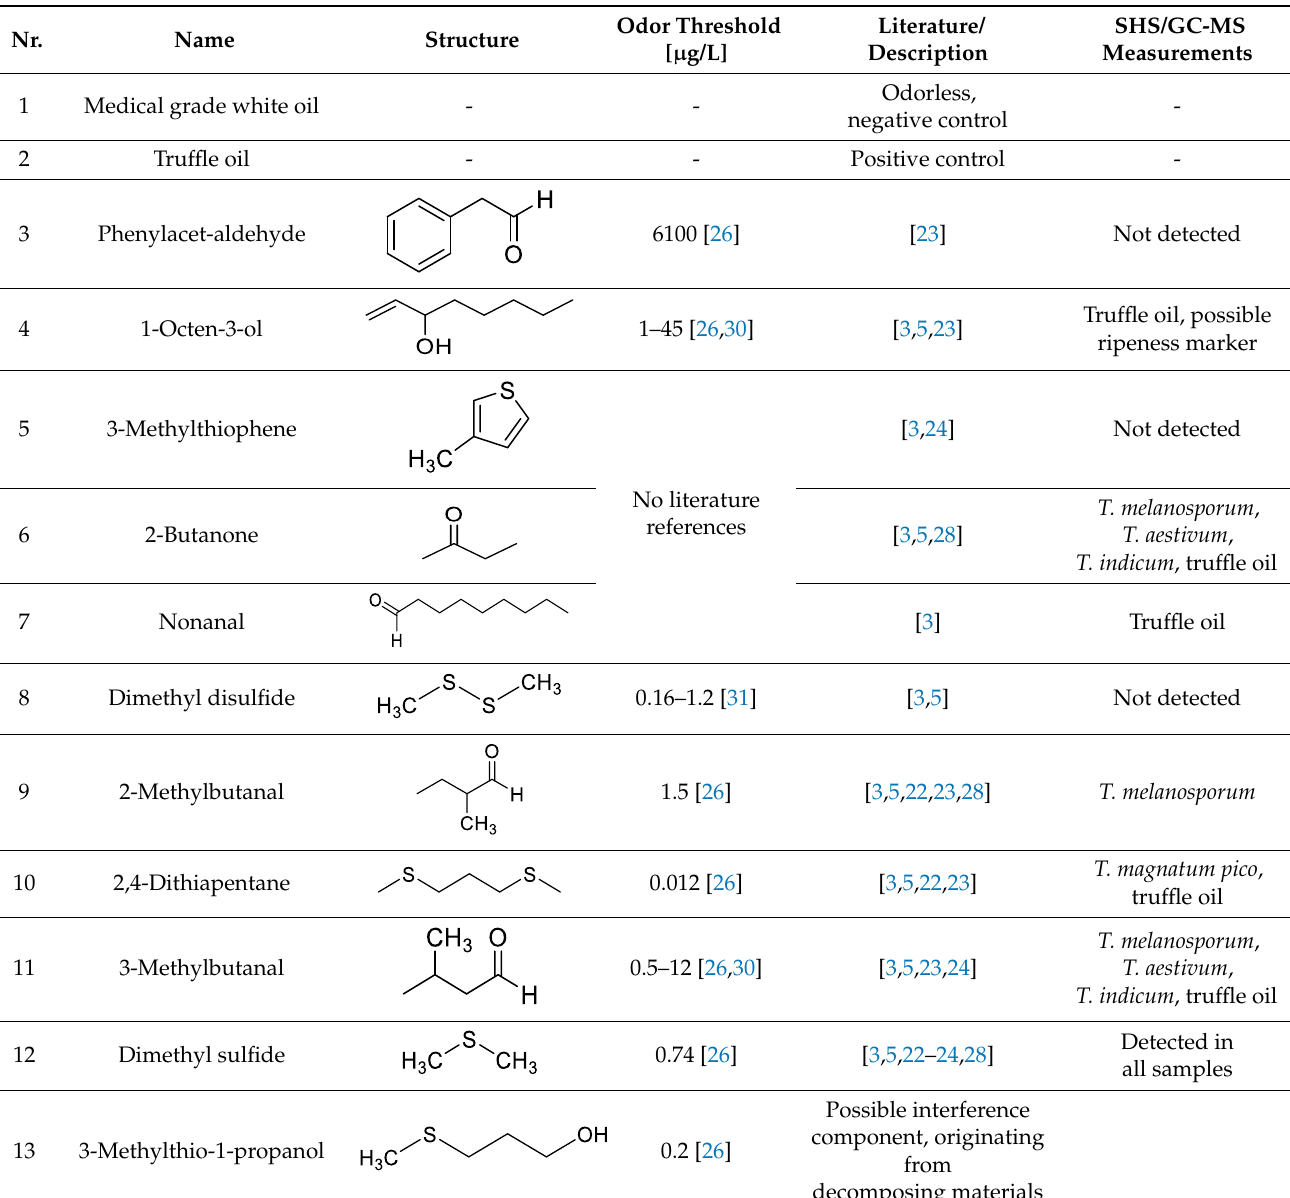
Table 2. Overview of the selected marker substances, their odor threshold values, literature reference for occurrence in truffles, and results from SHS/GC-MS measurements.